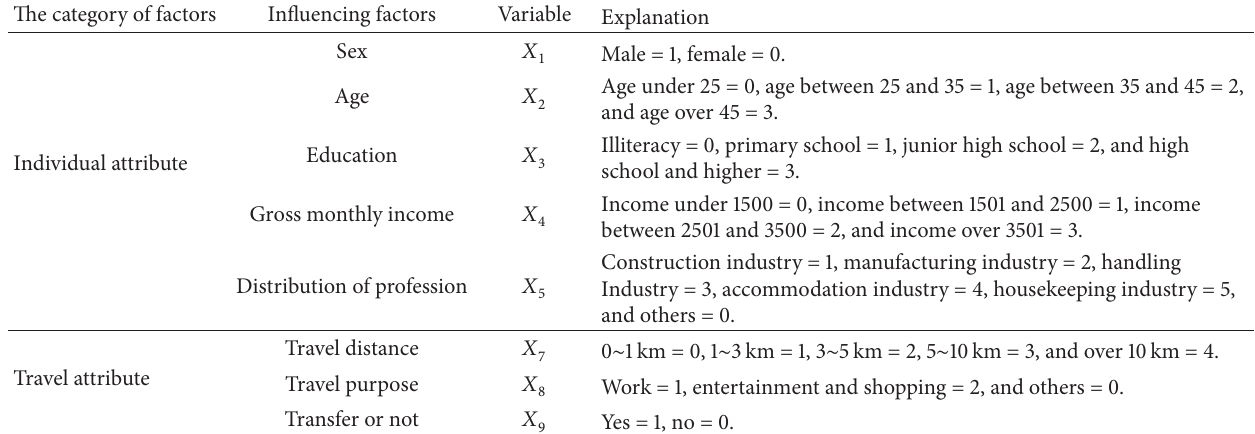
Table 1: Determination of influencing factors.